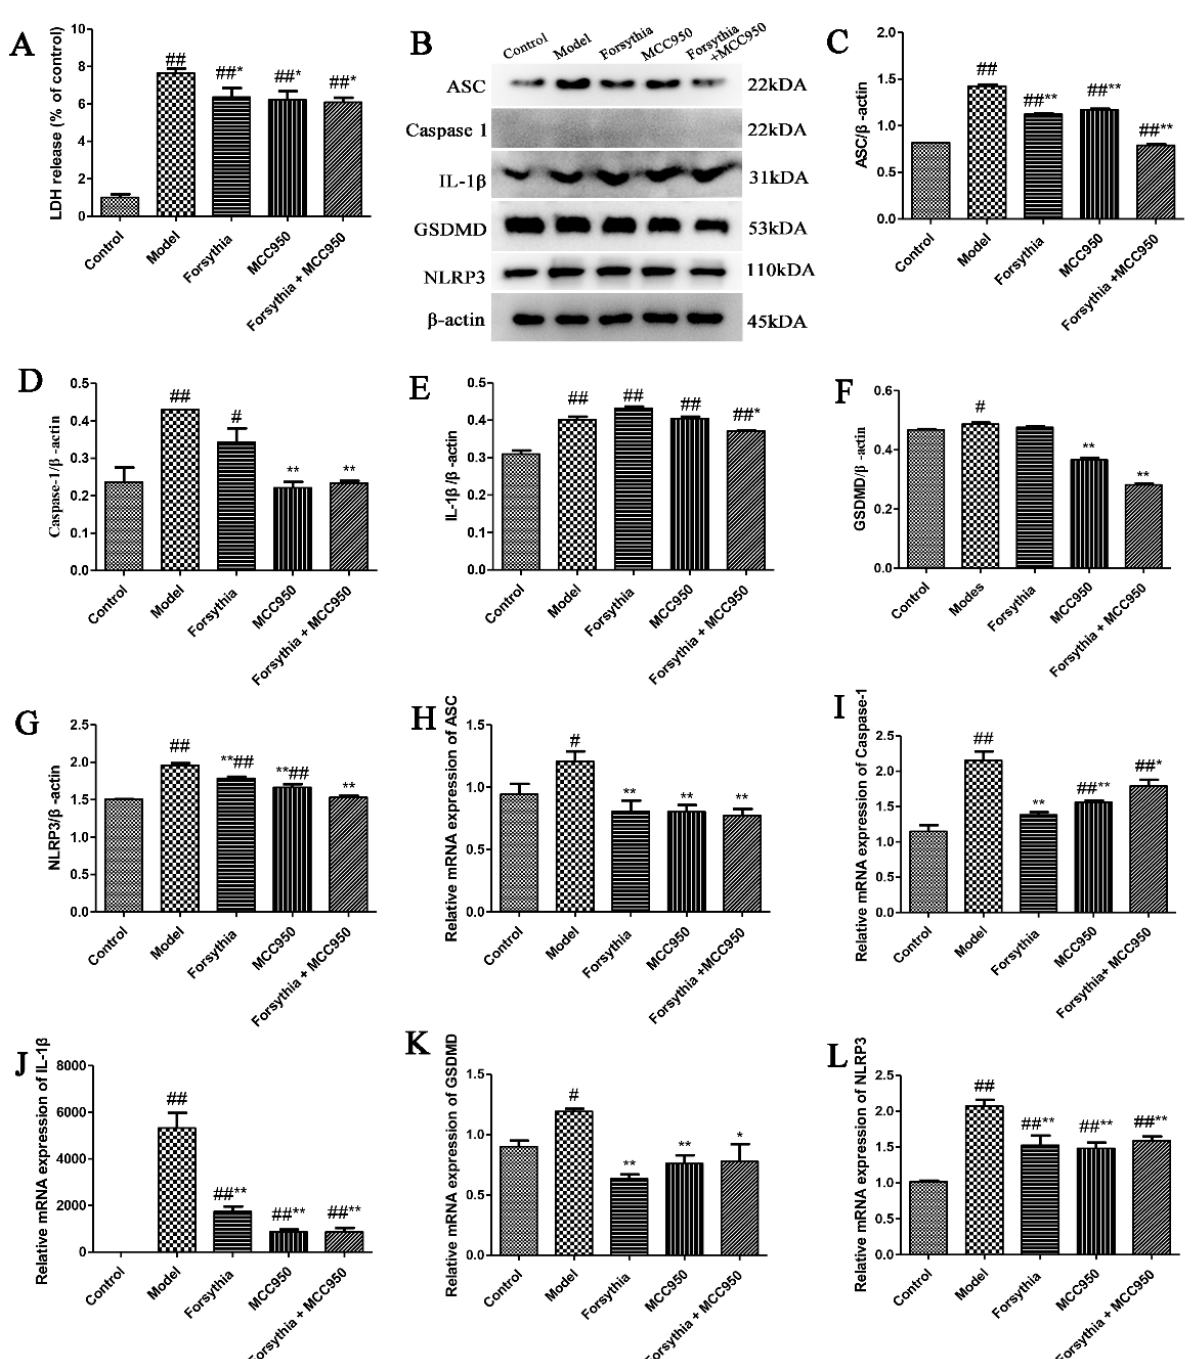
Figure 8. Forsythia suspensa extract may block the occurrence of pyroptosis by inhibiting the activation of NLRP3. ( A ) LDH levels in J774A.1 cells. ( B – G ) Western blot analysis of ASC, Caspase-1, IL-1 β , GSDMD and NLRP3. ( H – L ) qRT–PCR detection of ASC , Caspase-1 , IL-1 β , GSDMD and NLRP3 gene expression levels. Data represent at least three independent experiments. The results are shown as the mean ± SEM. # p < 0.05, and ## p < 0.01 compared with the control group; * p < 0.05, and ** p < 0.01 compared with the model group; #** means # and **; ##** means ## and **.